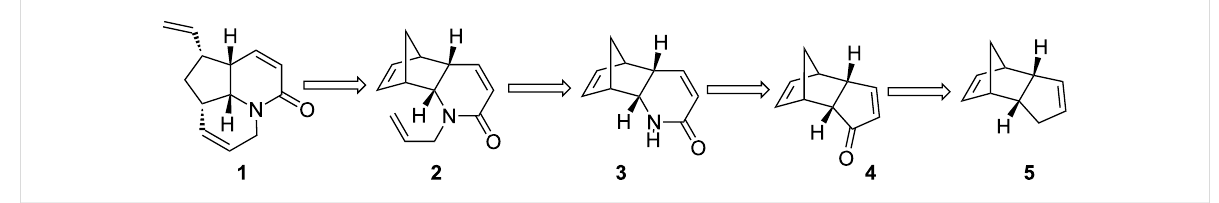
Figure 1: Retrosynthetic analysis of tricyclic amide 1 .